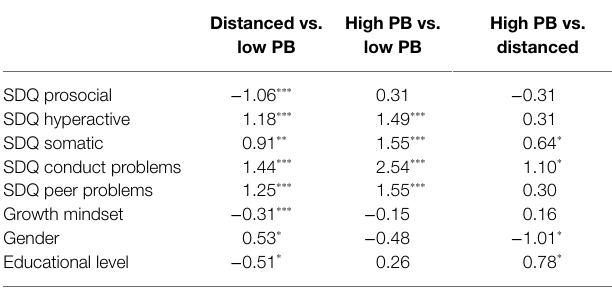
TABLE 3 | Antecedents of parental burnout profiles.